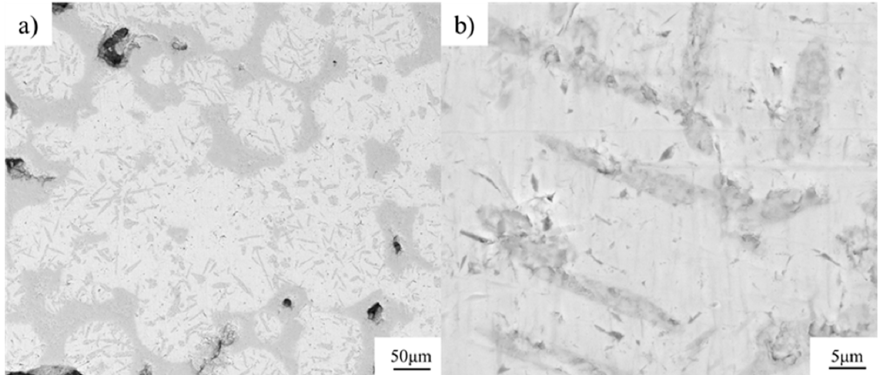
Figure 7. SEM backscattering of Ti-B 4 C composites; ( b ) is the local amplification of ( a ). The XRD phase compositions of the Ti-B 4 C core-shell structure before sintering, after ball milling and the as-sintered composite were compared and analyzed. The results are